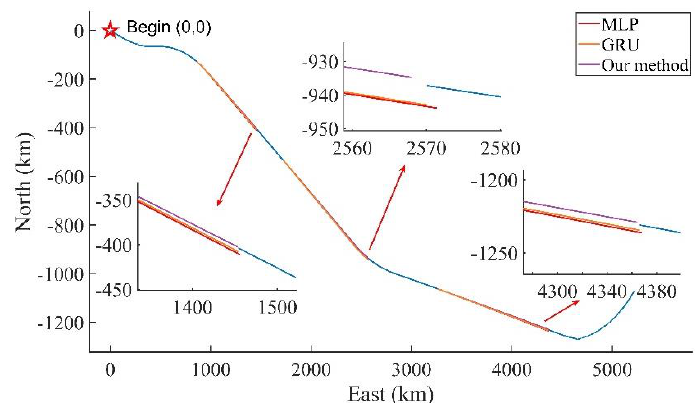
Figure 21. The trajectories of periods #1-3 of Experiment 2. Table 5. Horizontal position error at the end of the different tunnels.